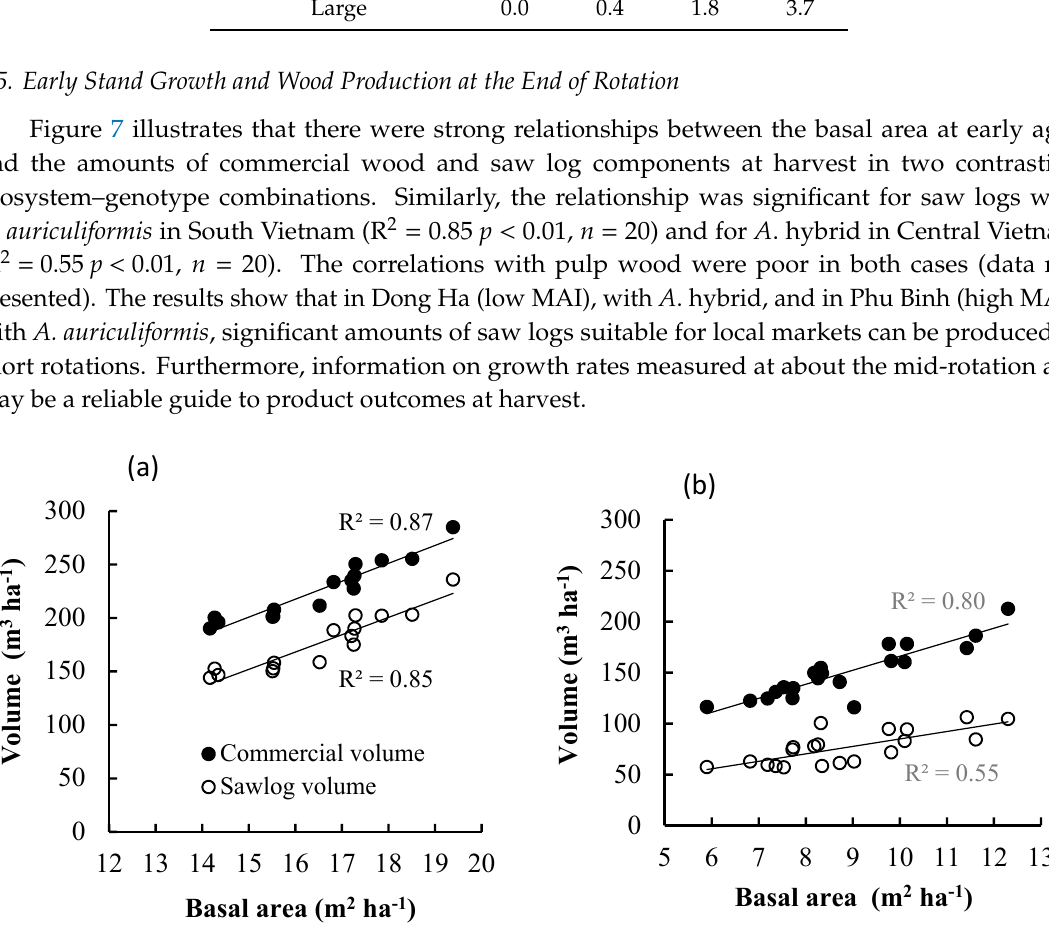
Figure 7. Relationships between basal area and wood production: ( a ) A. auriculiformis clones in Phu Binh, South Vietnam, basal area at age four and wood volumes at seven years, ( b ) A. mangium × A. auriculiformis hybrid clones in Dong Ha, Central Vietnam, basal area at 3.2 years and volume at 7.6 years.